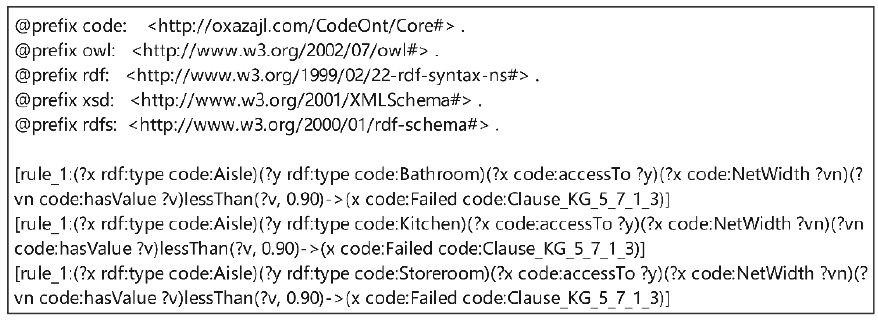
Figure 15. Checking rule “ CR-1 ” for clause 5.7.1.3.